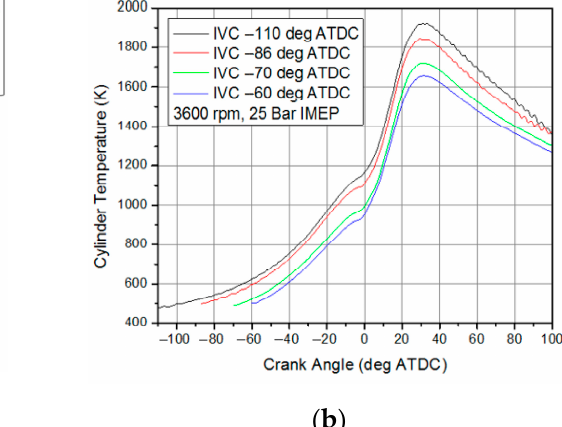
Figure 13. ( a ) Comparison of cylinder pressure with different intake closure angles; ( b ) Comparison of cylinder temperature with different intake closure angles.